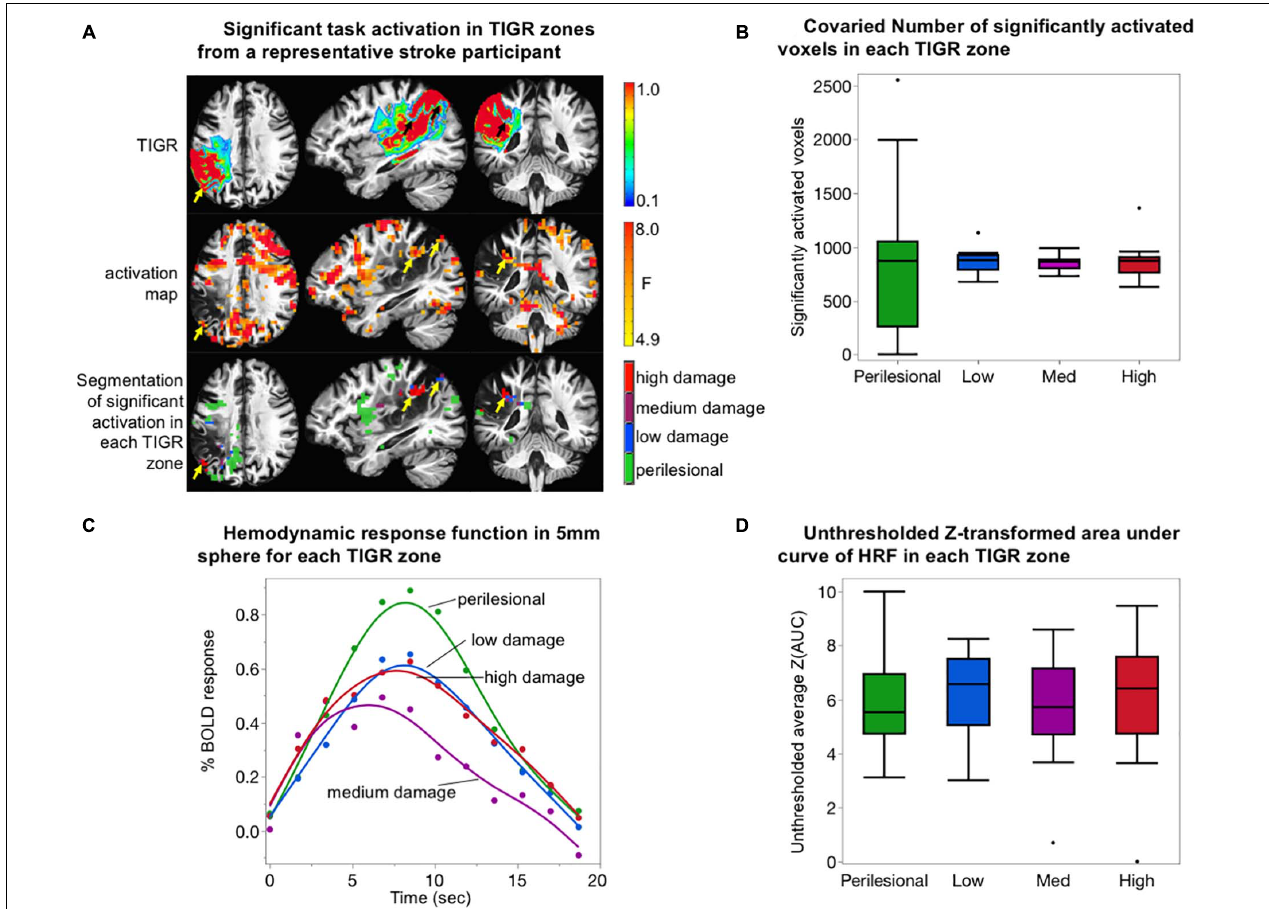
FIGURE 4 | Validation of tissue integrity gradation via T2w T1w ratio (TIGR) using task fMRI. (A) The TIGR maps (top row) and thresholded activation maps (middle row) of a representative participant (S03). The combination of these two modalities helps identify functional pericavitational areas with low, medium, and high damage. Perilesional areas with a significant task activity were identified with yellow/black arrows. (B) The co-varied number of significantly activated voxels in each TIGR zone for N = 14 participants. No difference in activation volume between tissue damage zones was detected. (C) Average HRF curves for N = 14 subjects in perilesional (green), low-damage (blue), medium-damage (purple), and high-damage (red) areas. The HRF curve for medium-damage areas is significantly lower than the other three tissue types. (D) Plot representing BOLD energetics in each tissue damage zone. No difference in BOLD energetics between tissue damage zones was